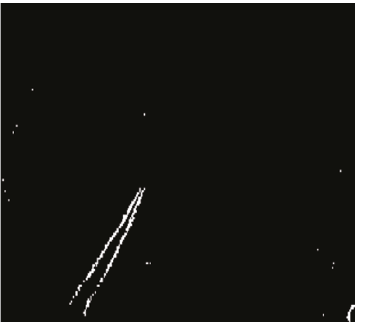
Figure 14: Image after boundary detection using our method with threshold of −